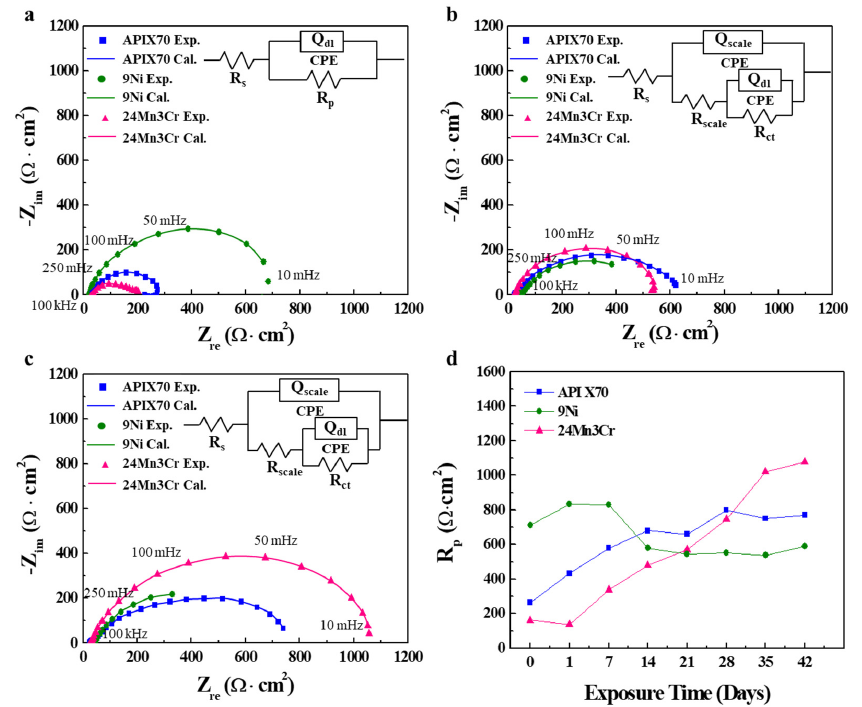
Figure 3. ( a – c ) Curve fitting to the Nyquist plots of the tested samples with different immersion times: ( a ) 1 h, ( b ) 21 days, and ( c ) 42 days; ( d ) Change in R p with an increasing immersion time. (Exp. and Cal. are the experimental and fitted data, respectively).